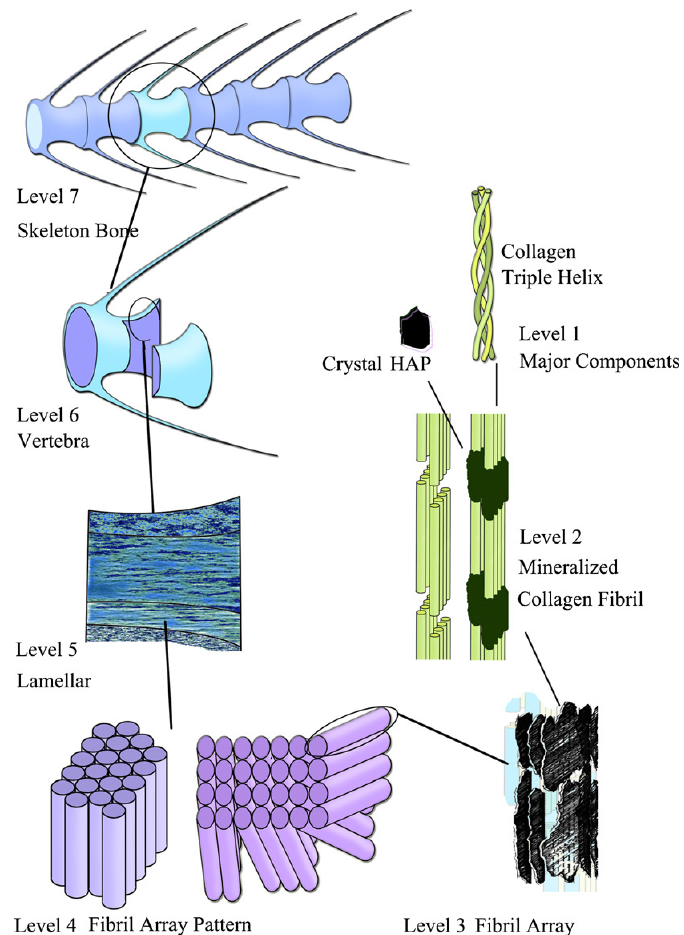
Figure 1. The seven hierarchical levels of organization of the zebrafish skeleton